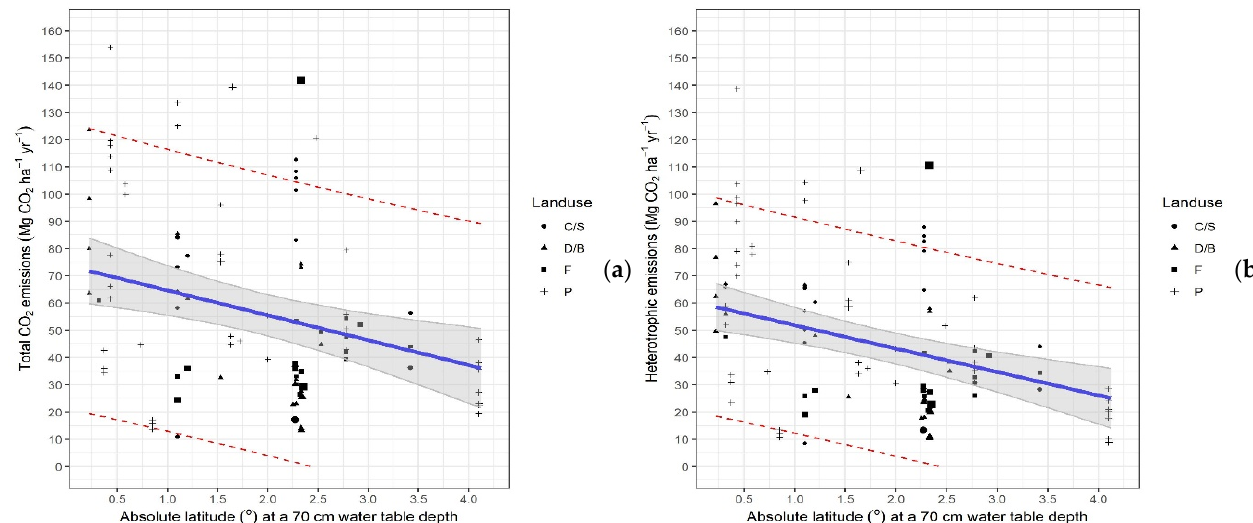
Figure 5. Relationship between absolute latitude at 70 cm water table depth and ( a ) total CO 2 emissions and ( b ) heterotrophic emissions of all land uses. Solid blue lines represent the estimates of the population mean, shaded grey bands indicate the 95% CIs of population mean estimates, dashed red lines indicate the 95% prediction intervals for the potential CO 2 values of future samples, while the four shapes (circles, triangles, squares, and crosses) indicate the observation values in the land use classes, where C/S = cropping/shrubland, D/B = drained/burnt, F = forest, and P = plantation.